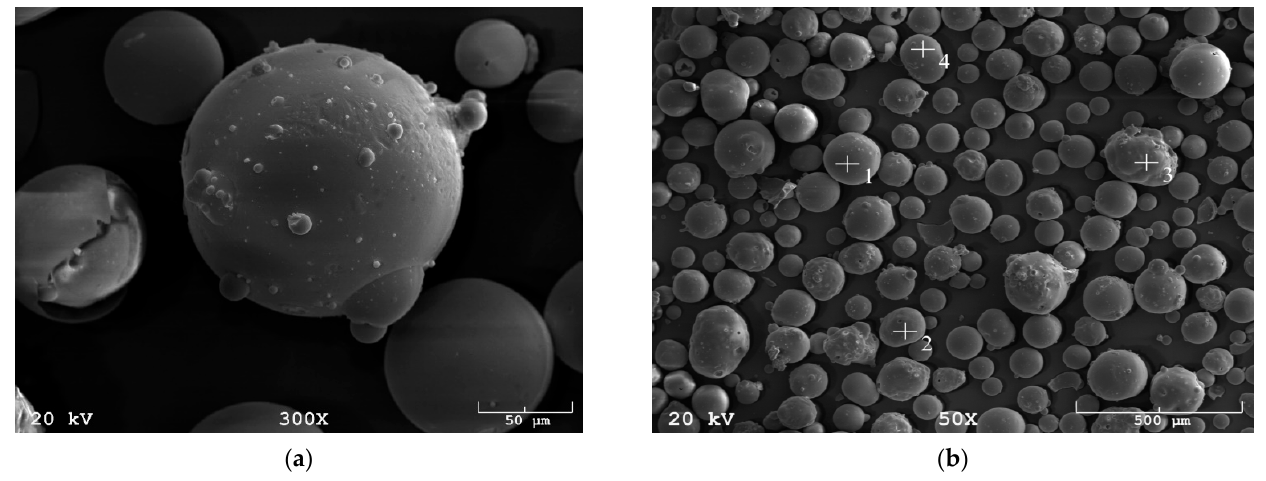
Figure 3. ( a ) SEM image: microspheres, magnification 300× ( b ) SEM image: microspheres, magnification 50×. Two types of fibers were selected for the tests: steel fibers (LA MATASSINA S.R.L., Isola Vicentina, Italy) and carbon fibers (P.P.H.U. SURFPOL Jacek Wo ź niak, Rawa Ma-